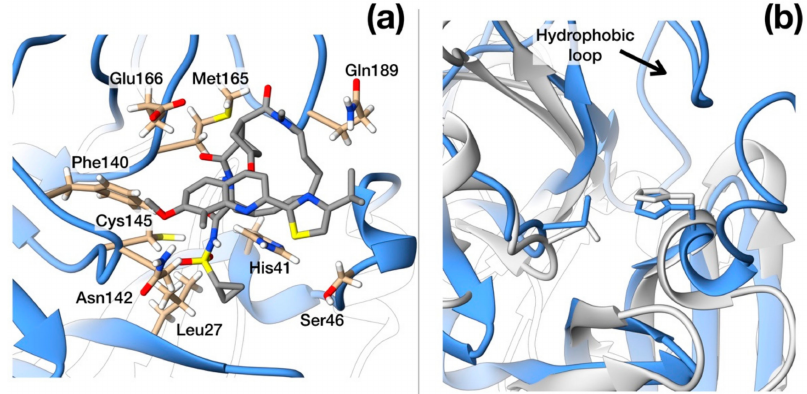
Figure 3. Structural details of SARS–CoV-2 protease. ( a ) Ribbon representation of protease active site with side-chains of residues that interact with Simeprevir shown in full atom details. ( b ) Ribbon representation of the crystallographic structures of SARS–CoV-2 (blue, PDB ID: 6LU7) and HCV protease (lightgray, PDBID:3KEE)superimposed.ThehydrophobicloopPhe181–Phe185ofSARS-CoV-2protease is evident on the upper side and is absent in HCV homologue. N, O, C and S atoms are colored in blue, red, gray and yellow